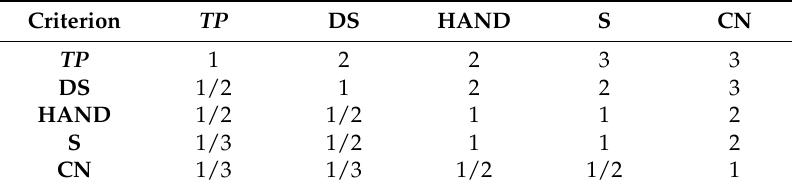
Table A4. Pairwise comparison for flood hazard S4.